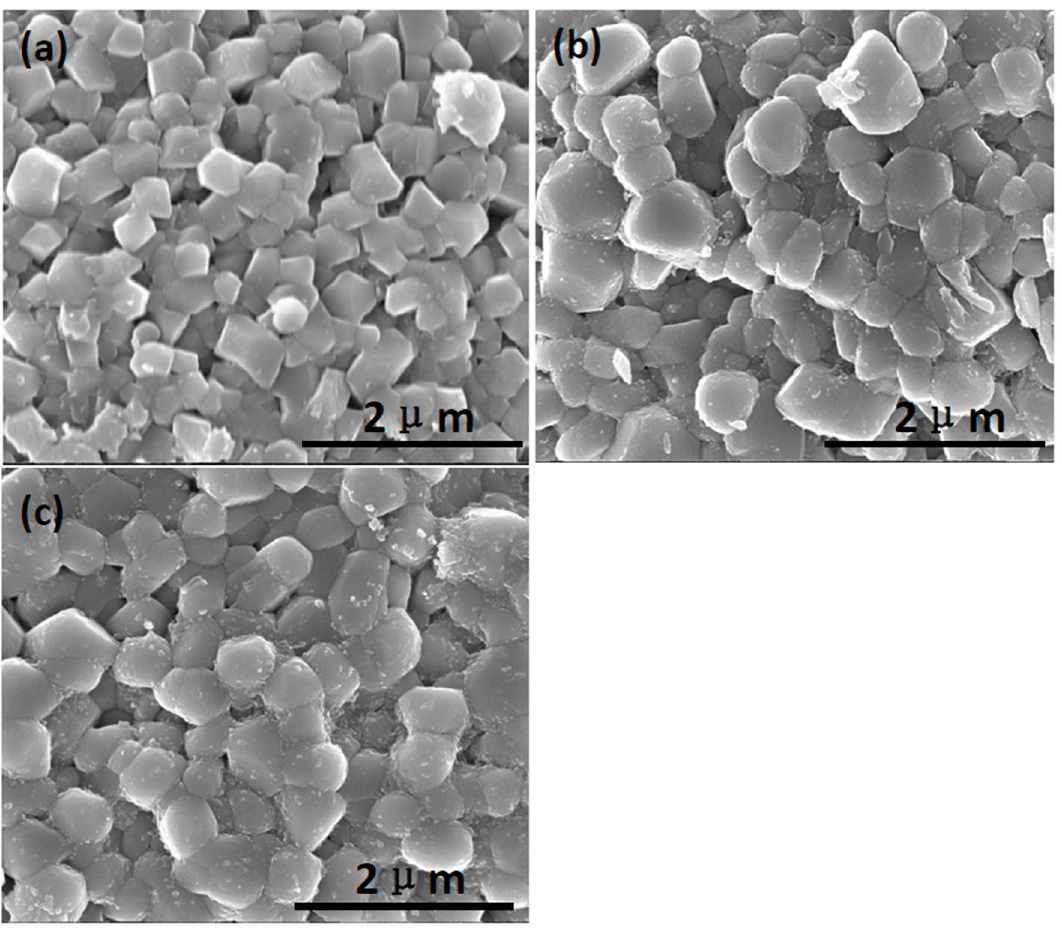
Figure 1. SEM images of the Li(Ni 0.6 Co 0.2 Mn 0.2 )O 2 powders coated with ( a ) 0.06 wt %; ( b ) 0.08 wt %; and ( c ) 0.12 wt % as Al 2 O 3 , and annealed at 500 °C for 4 h.